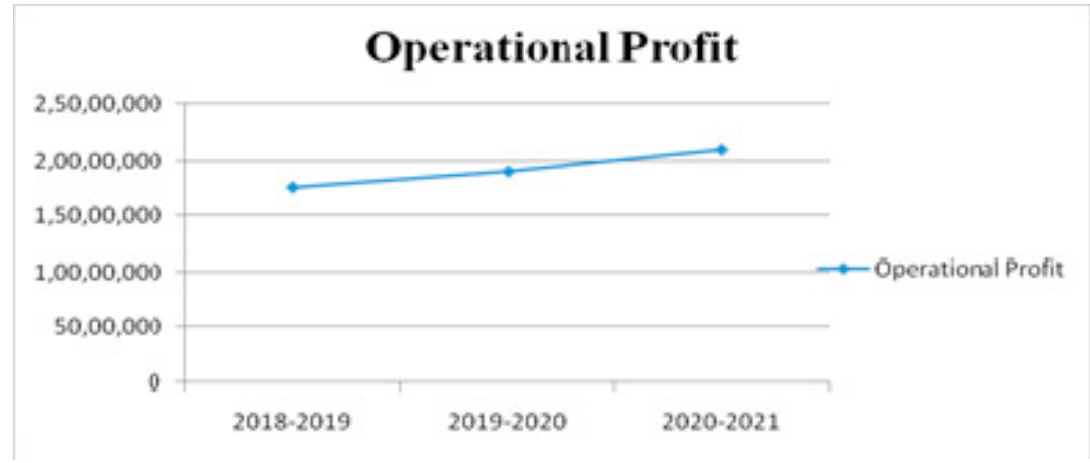
Figure 7. Line Graph showing increasing trends of operational profit last three years.